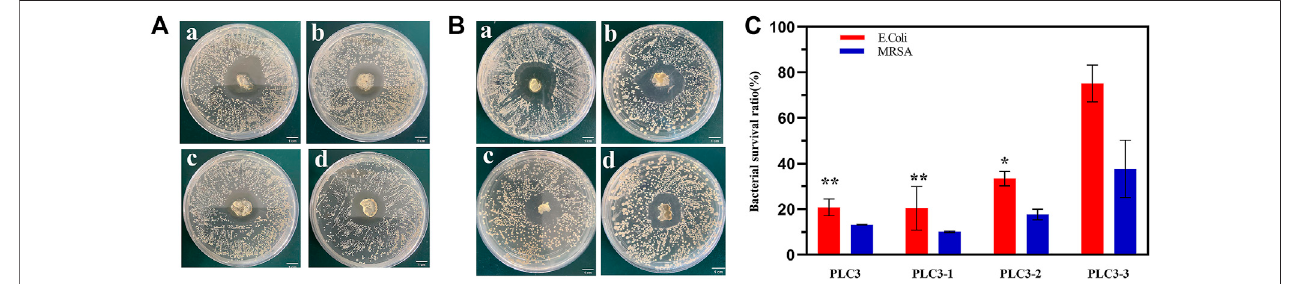
FIGURE 4 | The inhibitor zone test against (A) E. Coli and (B) MRSA on a) PLC3-1, b) PLC3, c) PLC3-2, and d) PLC3-3; scale bar: 1 cm. (C) Agar plate colony counting test against E. Coli and MRSA on PLC3, PLC3-1, PLC3-2 and PLC3-3, with the data shown as means ± SD ( n (cid:1) 3, ** p < 0.01, * p <